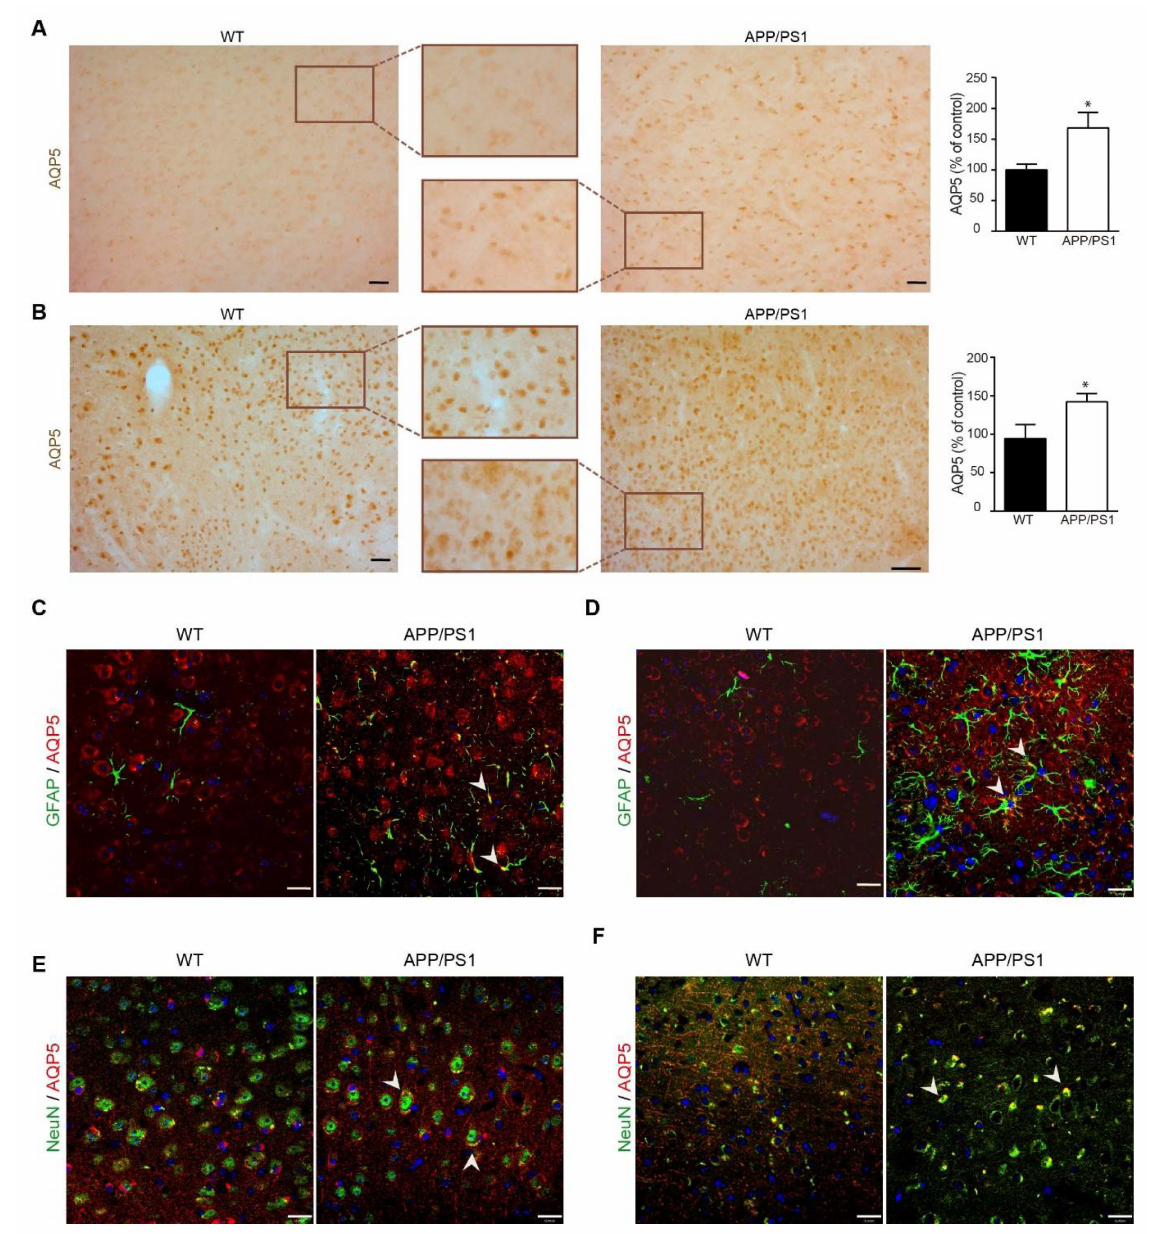
Figure 4. Analysis of AQP5 expression in brain cell populations. Localization of AQP5 in cerebral cortex from APP/PS1 transgenic and nontransgenic mice was detected by immunostaining and immunofluorescence. ( A , B ) AQP5 stained sections of cerebral cortex from ( A ) 6- and ( B ) 12-month-old APP/PS1 and wt mice. All sections were counterstained with hematoxylin. In the right histograms, quantification of the AQP5 signal ( n = 8, per group) is shown. Inserts show higher magnification views. ( C – F ) Representative confocal images showing AQP5 (red) in astrocytes inmunostained with anti-GFAP (green) staining in ( C ) 6- and ( D ) 12-month-old APP/PS1 and wt mice. Representative confocal images showing AQP5 (red) in neurons inmunostained with anti-NeuN (green) staining in ( E ) 6- and ( F ) 12-months-old APP/PS1 and wt mice. White arrows indicate colocalization of the corresponding antibodies. Scale bar = 20 µ m. Data are represented as mean ± SEM.